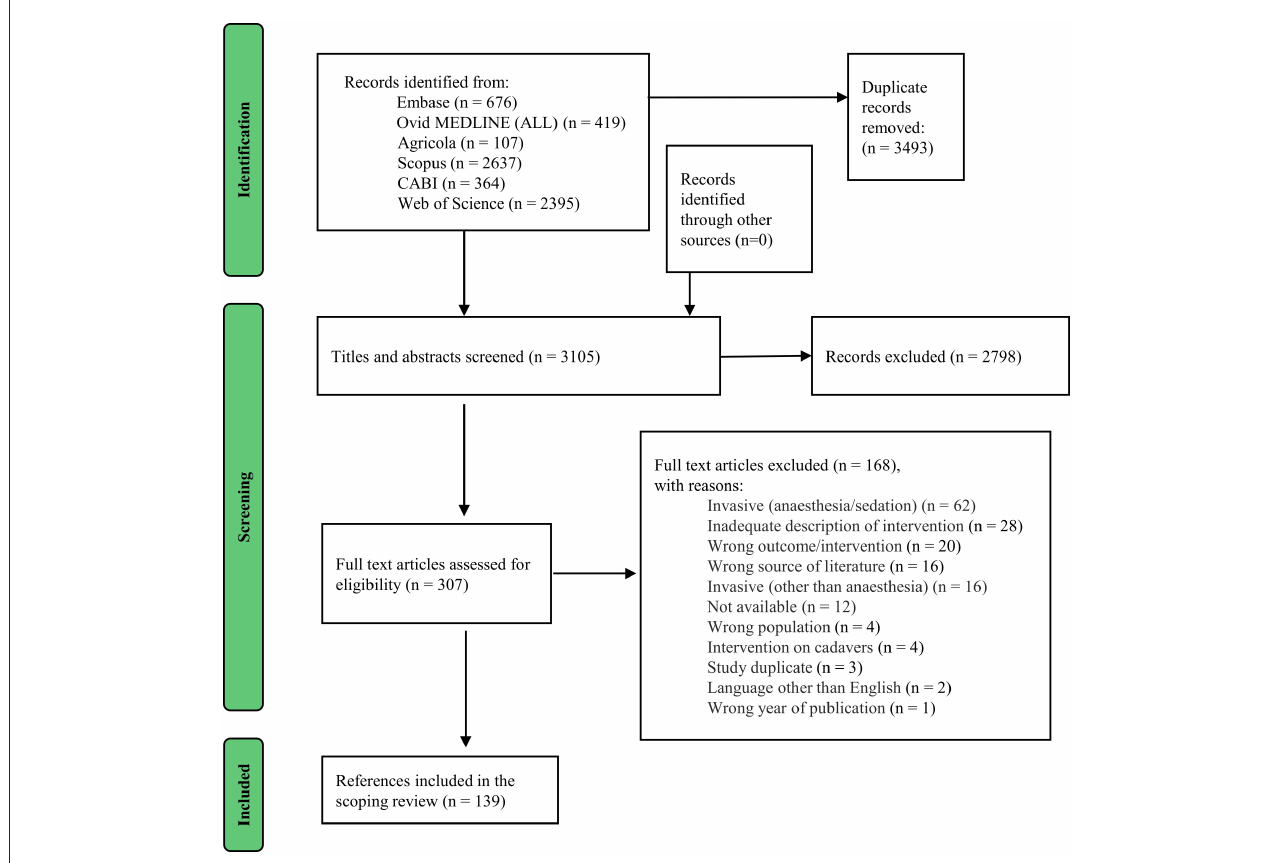
FIGURE1 Flow diagram of the selection process (19,